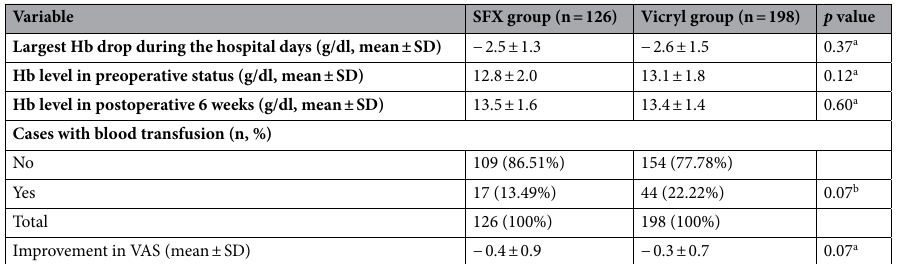
Table 3. Clinical outcomes according to suture type of THA patients. Hb, hemoglobin; SD, standard deviation; VAS, Visual Analogue Scale. a By independaent t-test. b By chi-square test.